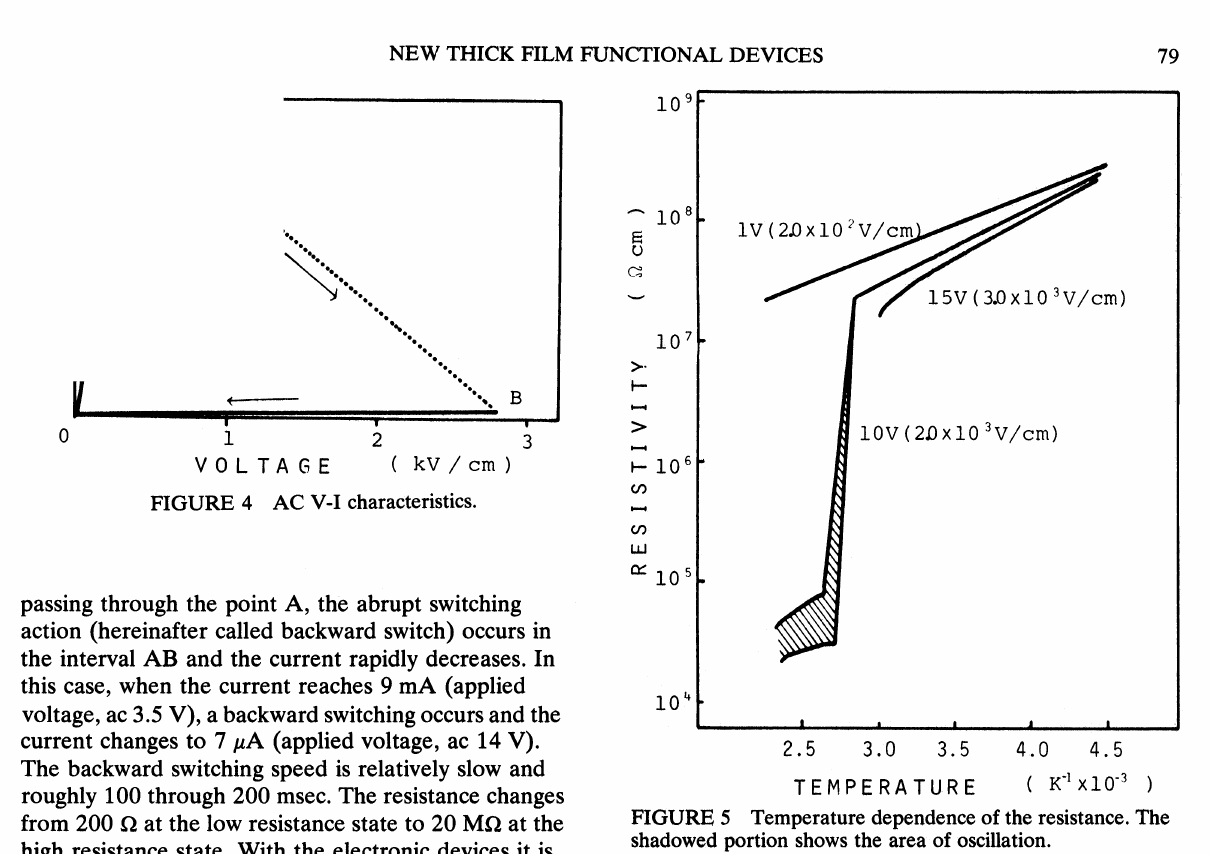
FIGURE 5 Temperature dependence of the resistance. The shadowed portion shows the area of oscillation. seen in this figure, threshold voltage is in proportion to the reciprocals of the